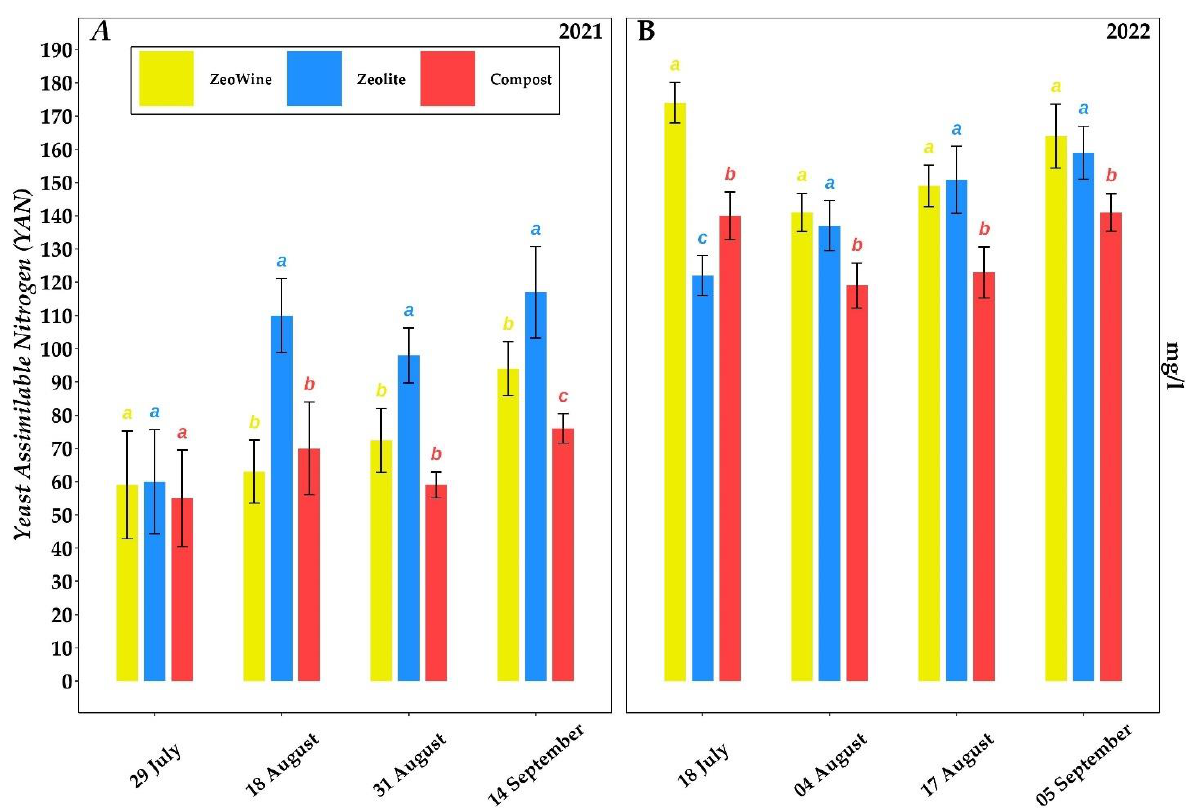
Figure 8. Yeast assimilable nitrogen (YAN). Yeast assimilable nitrogen (YAN) of Vitis vinifera treated with Zeowine, zeolite, and compost during two seasons (2021 – 2022, ( A ) and ( B )). Measurements were conducted four times: full veraison (29 July 2021 and 18 July 2022), mid-maturation (18 August 2021 and 4 August 2022), full maturation (31 August 2021 and 17 August 2022), and harvest (14 September 2021 and 5 September 2022). Data (mean ± SE, n = 10) were subjected to one-way ANOVA. The bars represent the standard deviation. Different letters indicate significant differences between Zeowine, Zeolite, and Compost (LSD test, p ≤ 0.05).